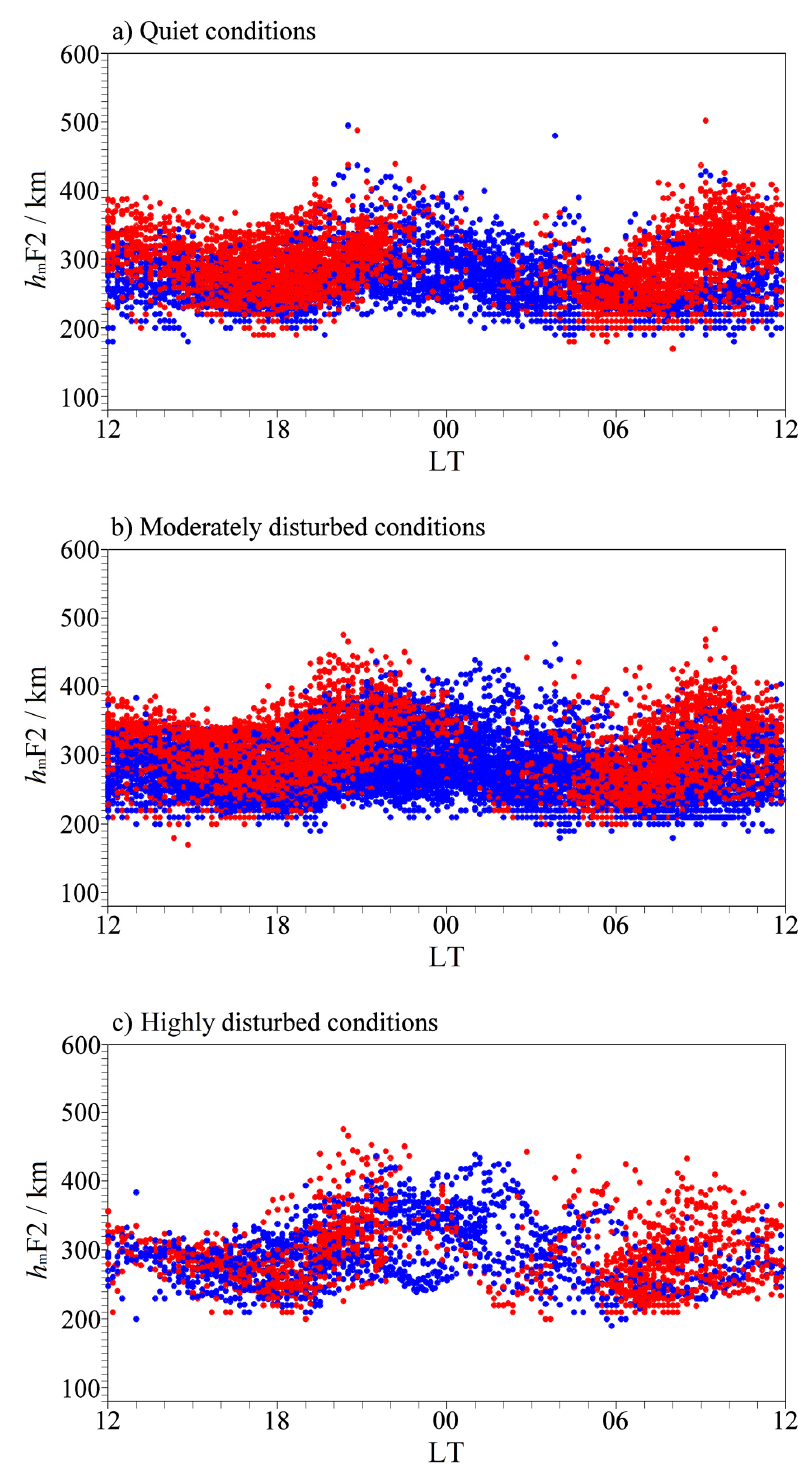
Figure 6. Overlapping h m F2 trends as a function of LT for the days in which spread F was not observed (blue dots), and days in which it was observed for more than 25% of the time (red dots) under ( a ) quiet conditions, ( b ) moderately disturbed conditions, and ( c ) highly disturbed conditions.